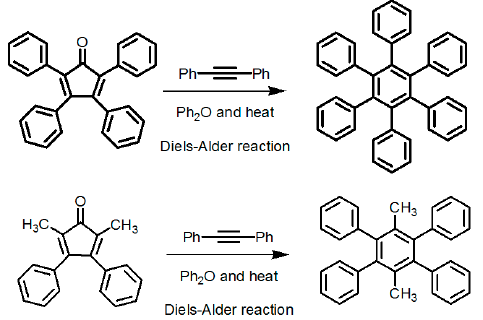
Figure 26. Synthesis routes of rigid cores in building motifs 30a and 30b . Molecules 2017 , 22 , 266